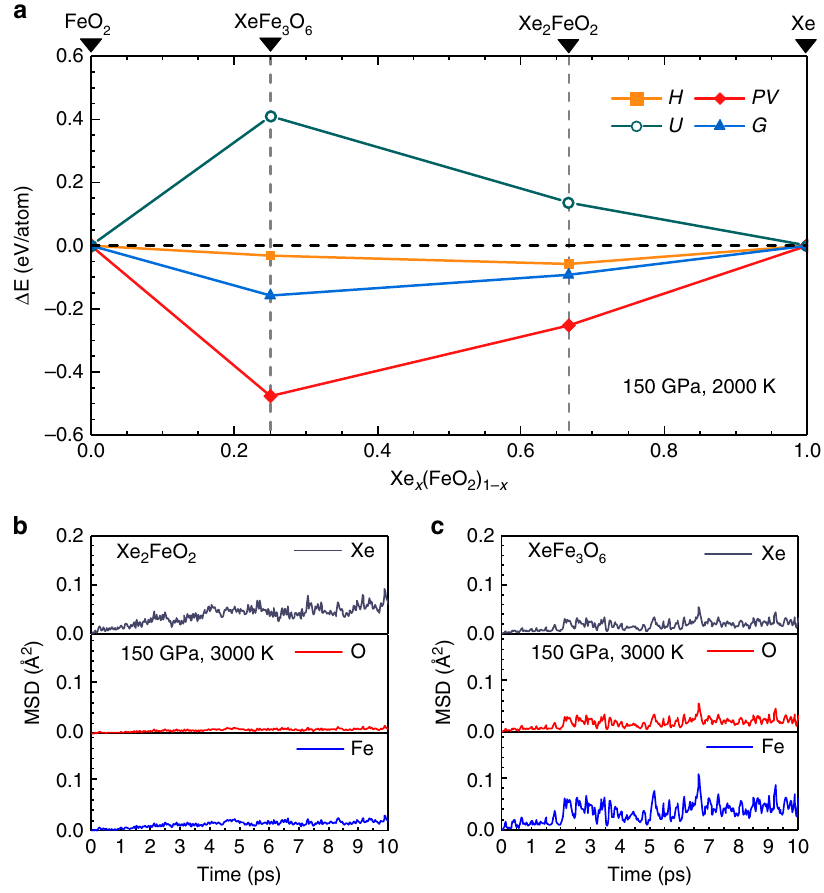
Fig. 3 Calculated energetic terms and the mean square deviations. a Various energetic term ( Δ E ) for the two Xe-Fe oxides, enthalpy ( H ), pressure – volume ( PV ) terms, internal energy ( U ), and Gibbs free energy ( G ) at 150 GPa, 2000 K. b Mean square deviations (MSD) of Xe, O, and Fe atomic positions in Xe 2 FeO 2 at 150 GPa, 3000 K. c MSD of Xe, O, and Fe atomic positions in XeFe 3 O 6 at 150 GPa, 3000